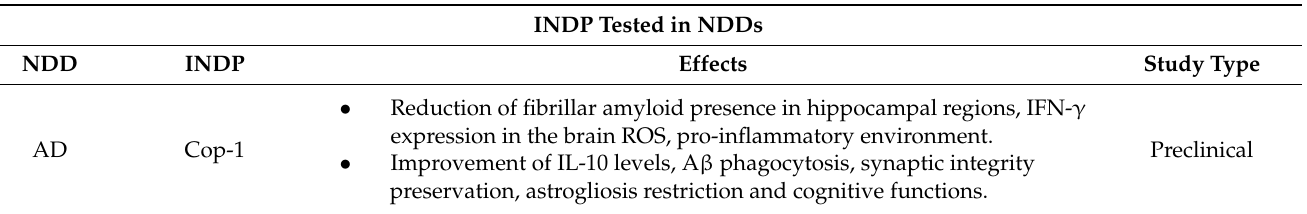
Table 1. INDP that have been tested for certain